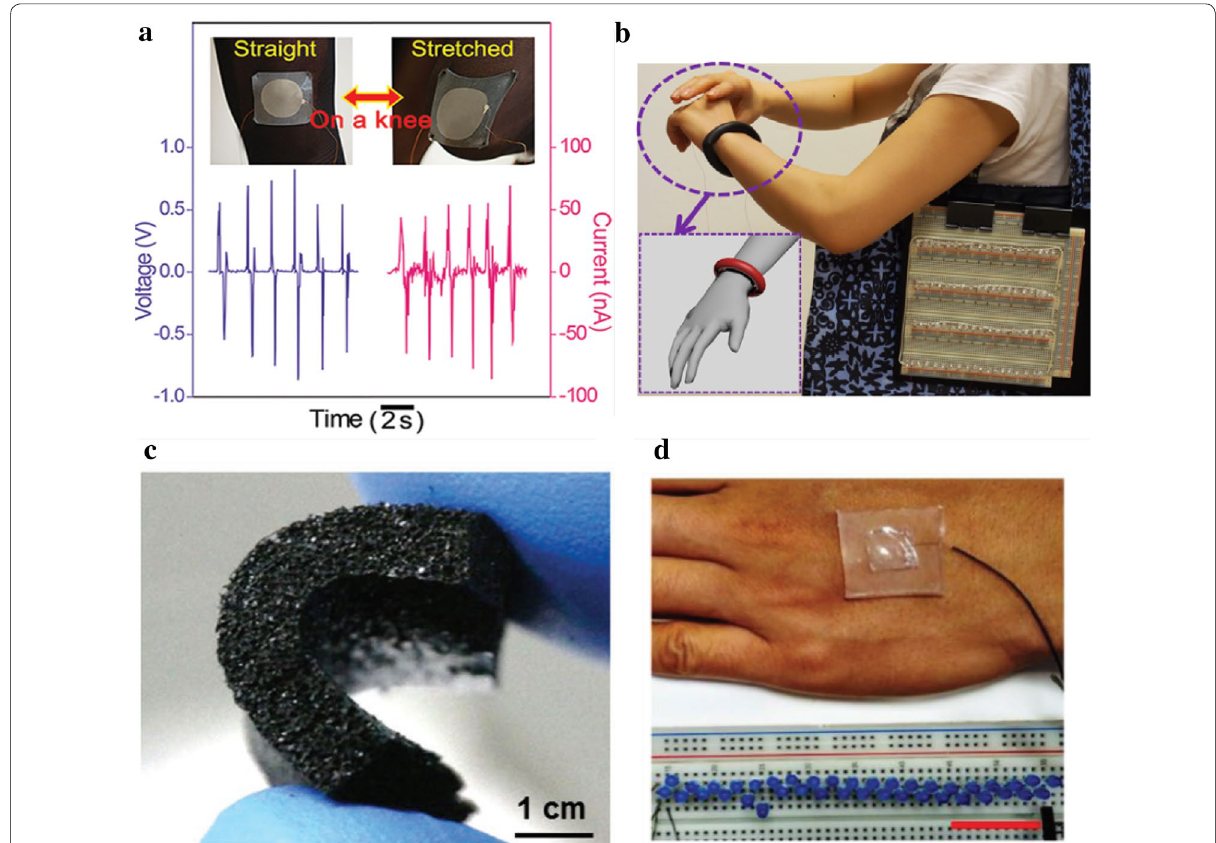
Fig. 8 Stretchable and self-healable conductors for applications of energy harvesting. a A type of hyper-stretchable elastic-composite energy harvester. Reproduced with permission [190]. Copyright 2015, WILEY–VCH. b A highly shape-adaptive, stretchable design based on conductive liquid for energy harvesting and self-powered biomechanical monitoring. Reproduced with permission [191]. c Stretchable porous CNT-elastomer hybrid nanocomposite for harvesting mechanical energy. Reproduced with permission [192]. Copyright 2015, WILEY–VCH. d Highly transparent, stretchable, and self-healing Ionic-skin triboelectric nanogenerators for energy harvesting. Reproduced with permission [193]. Copyright